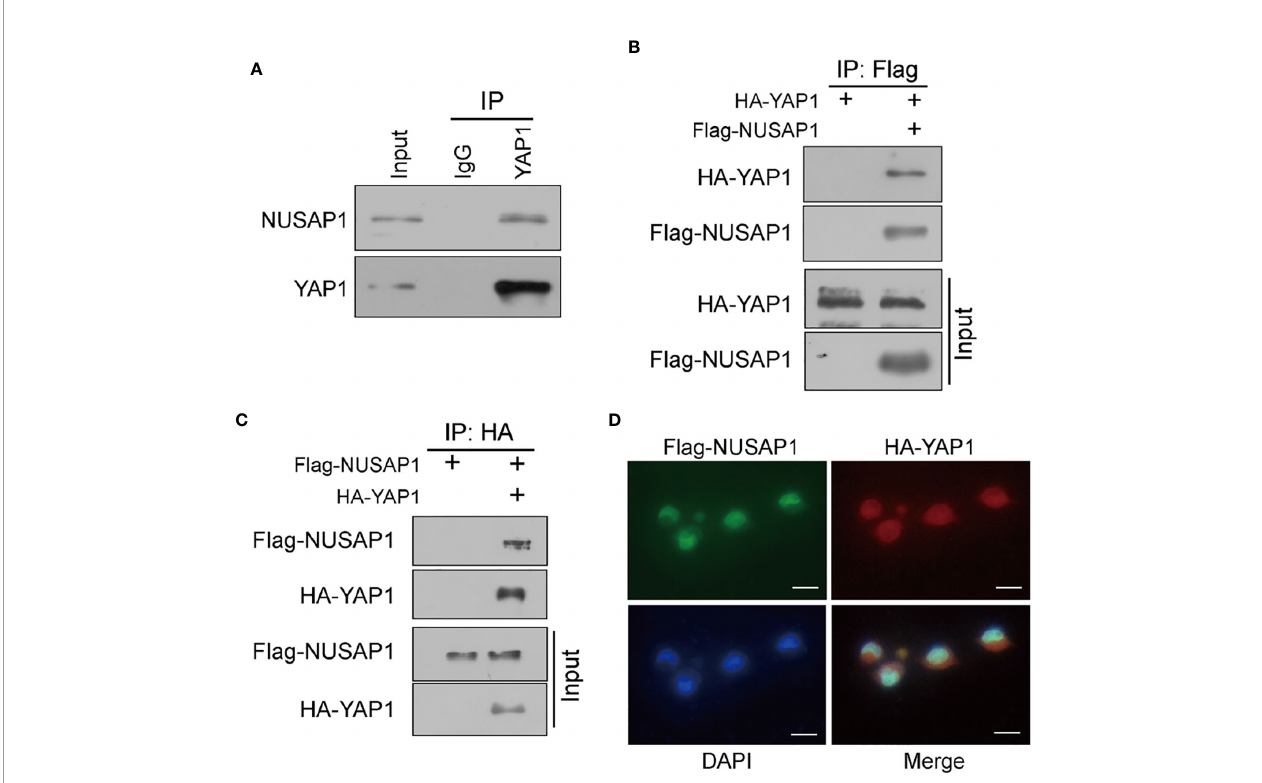
FIGURE 1 | NUSAP1 interacts with YAP1. (A) The interaction between endogenous NUSAP1 and YAP1. The BGC823 cell lysates were immunoprecipitated with anti-YAP1 or control immunoglobulin G (IgG), followed by WB analysis with anti-NUSAP1 and anti-YAP1. (B) WB analysis of coprecipitating proteins in IPs performed using anti-Flag beads on lysates prepared from BGC823 cells. (C) WB analysis of coprecipitating proteins in IPs performed using anti-HA beads on lysates prepared from SGC7901 cells. (D) Immuno fl uorescence of NUSAP1 and YAP1 staining in BGC823 cells (magni fi cation,